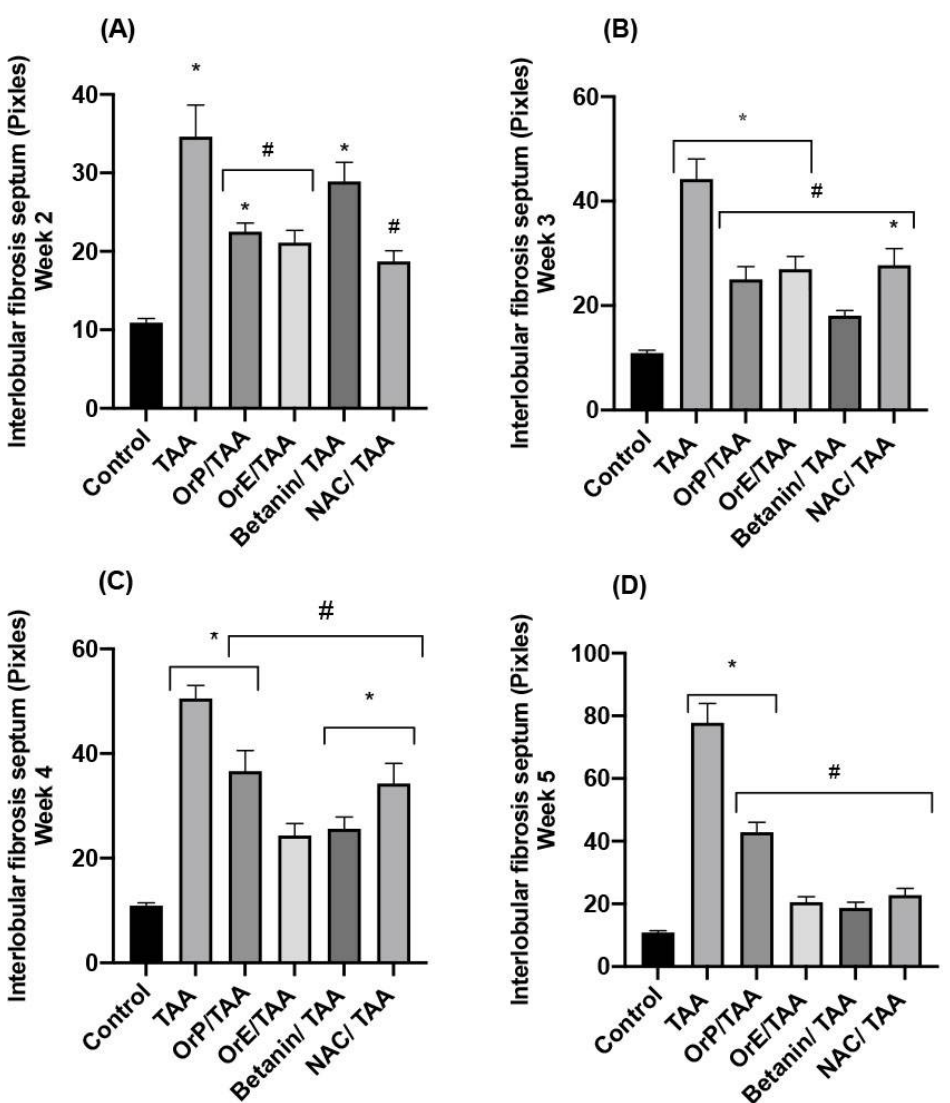
Figure 9. Measurements of interlobular fibrotic septa for the different treatments at different time points. ( A – D ) In all the evaluated weeks of treatment, OrP and OrE significantly decrease the thickness of the fibrosis septa. One-way ANOVA with Tukey’s post hoc test. * p < 0.05 compared to control group, # p < 0.05 compared to TAA group.